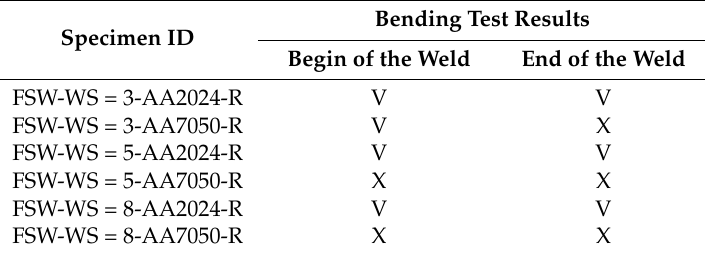
Table 4. Results of the bending test for the material